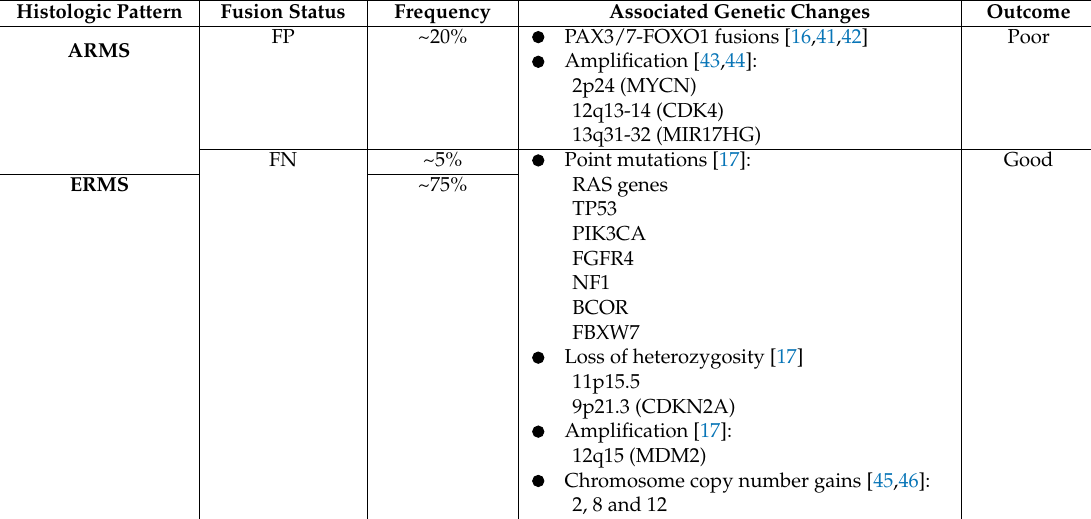
Table 1. RMS subtypes and their major associated genetic